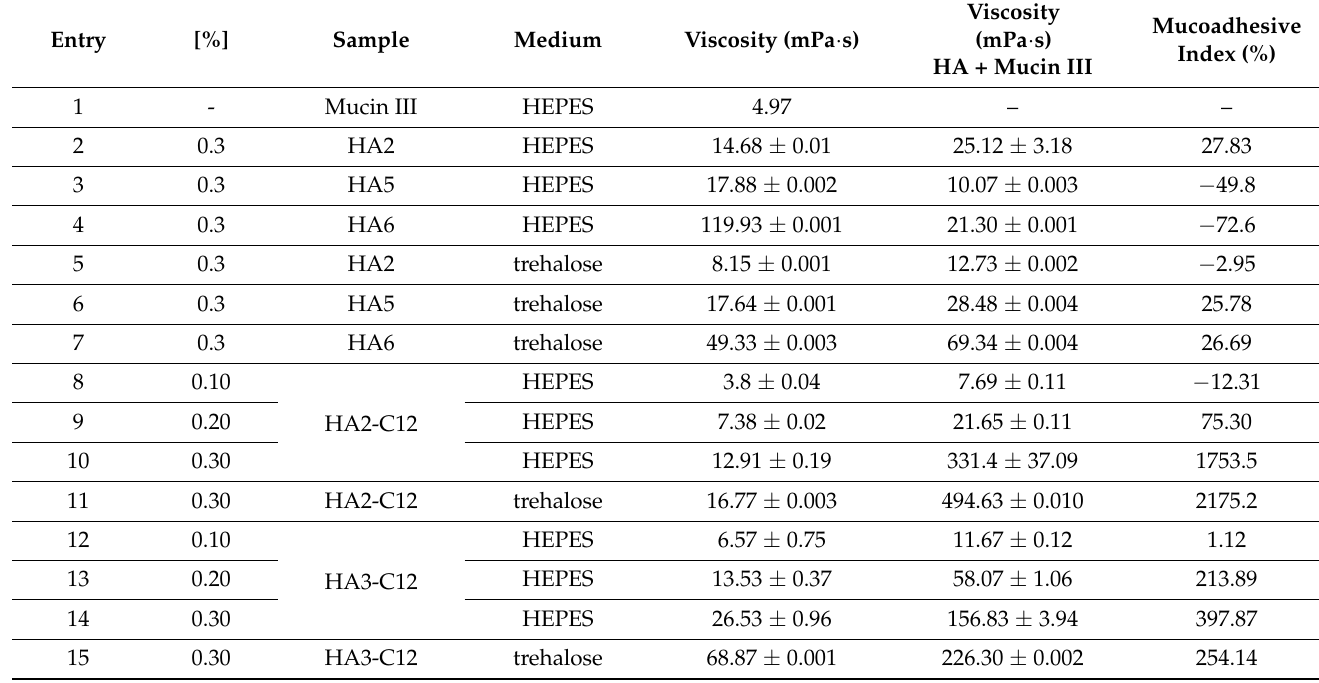
Table 2. Viscosity values and mucoadhesive index for HA (0.3%) and HA-C12 (0.1–0.3%) determined in the presence of mucin III. The values are reported as an average (mean value ± SD, n = 3) at shear rate of 33.9 s − 1